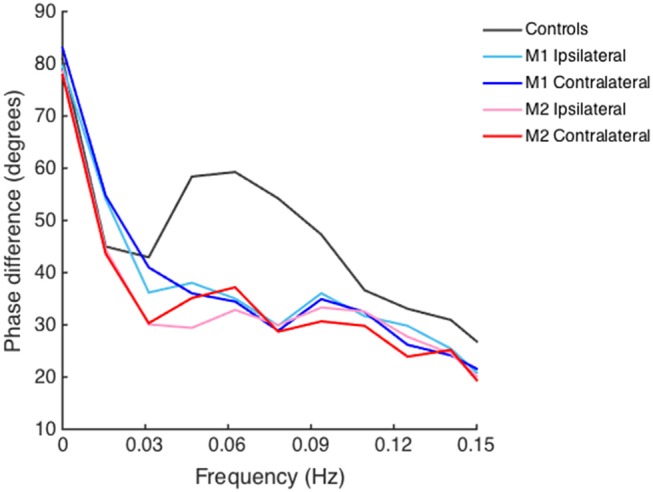
Phase difference of acute ischemic stroke (AIS) patients and healthy controls derived from transfer function analysis in frequency domain. Lines depicted with different colors denote phase difference on the ipsilateral and contralateral side of AIS patients and healthy controls. Bilateral decreased phase difference is shown in both measurement 1 (M1) and measurement 2 (M2) in AIS patients as compared to that in healthy controls in low-frequency range (0.06–0.12 Hz).